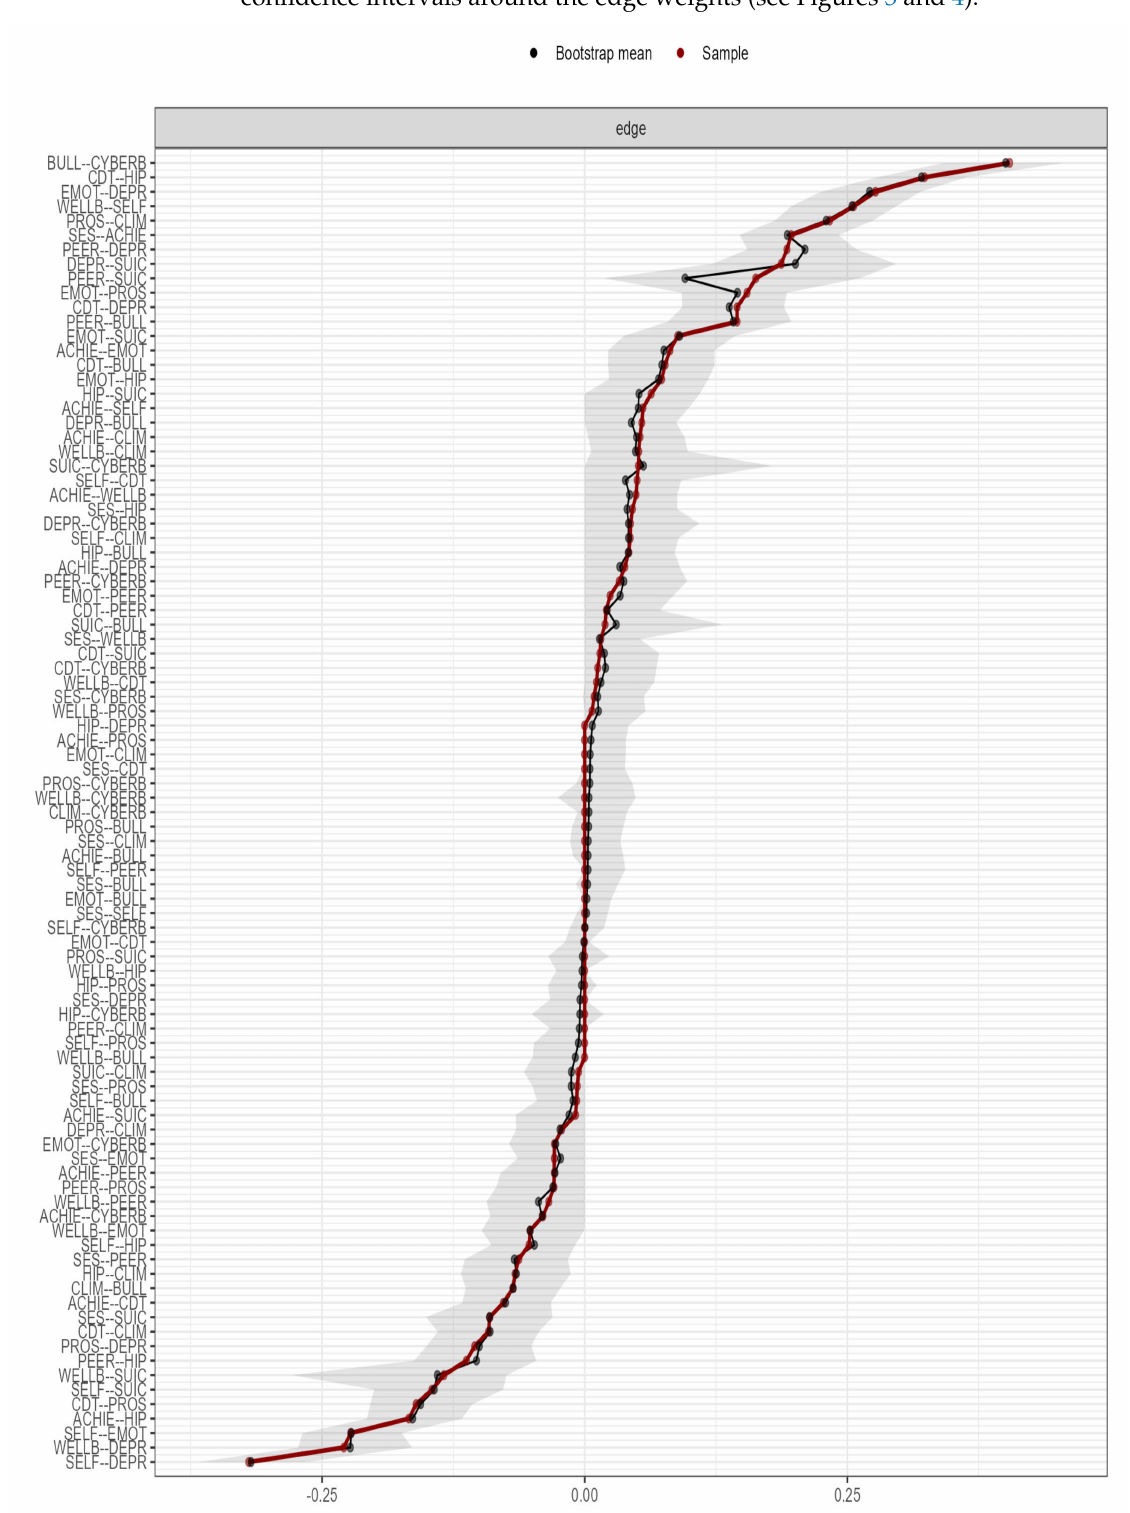
Figure 3. Accuracy of the edgeweight estimates (red line) and the 95% confidence intervals (grey bars) for the